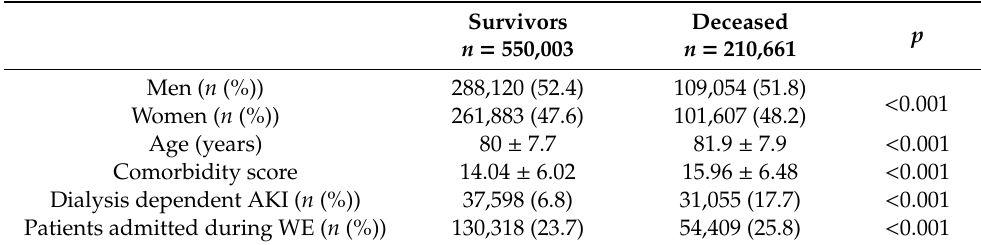
Table 3. Comparison between survivors and deceased subjects.